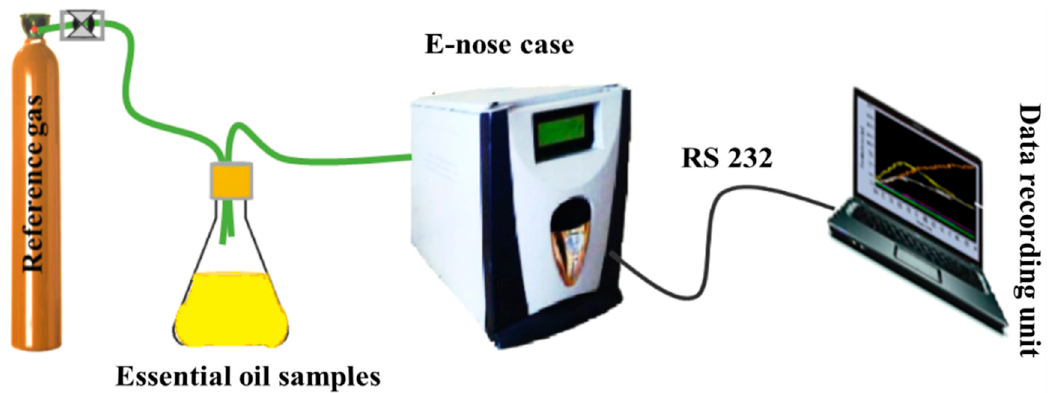
Figure 1. E-nose setup for essential oils (okoume and aiele) analysis.